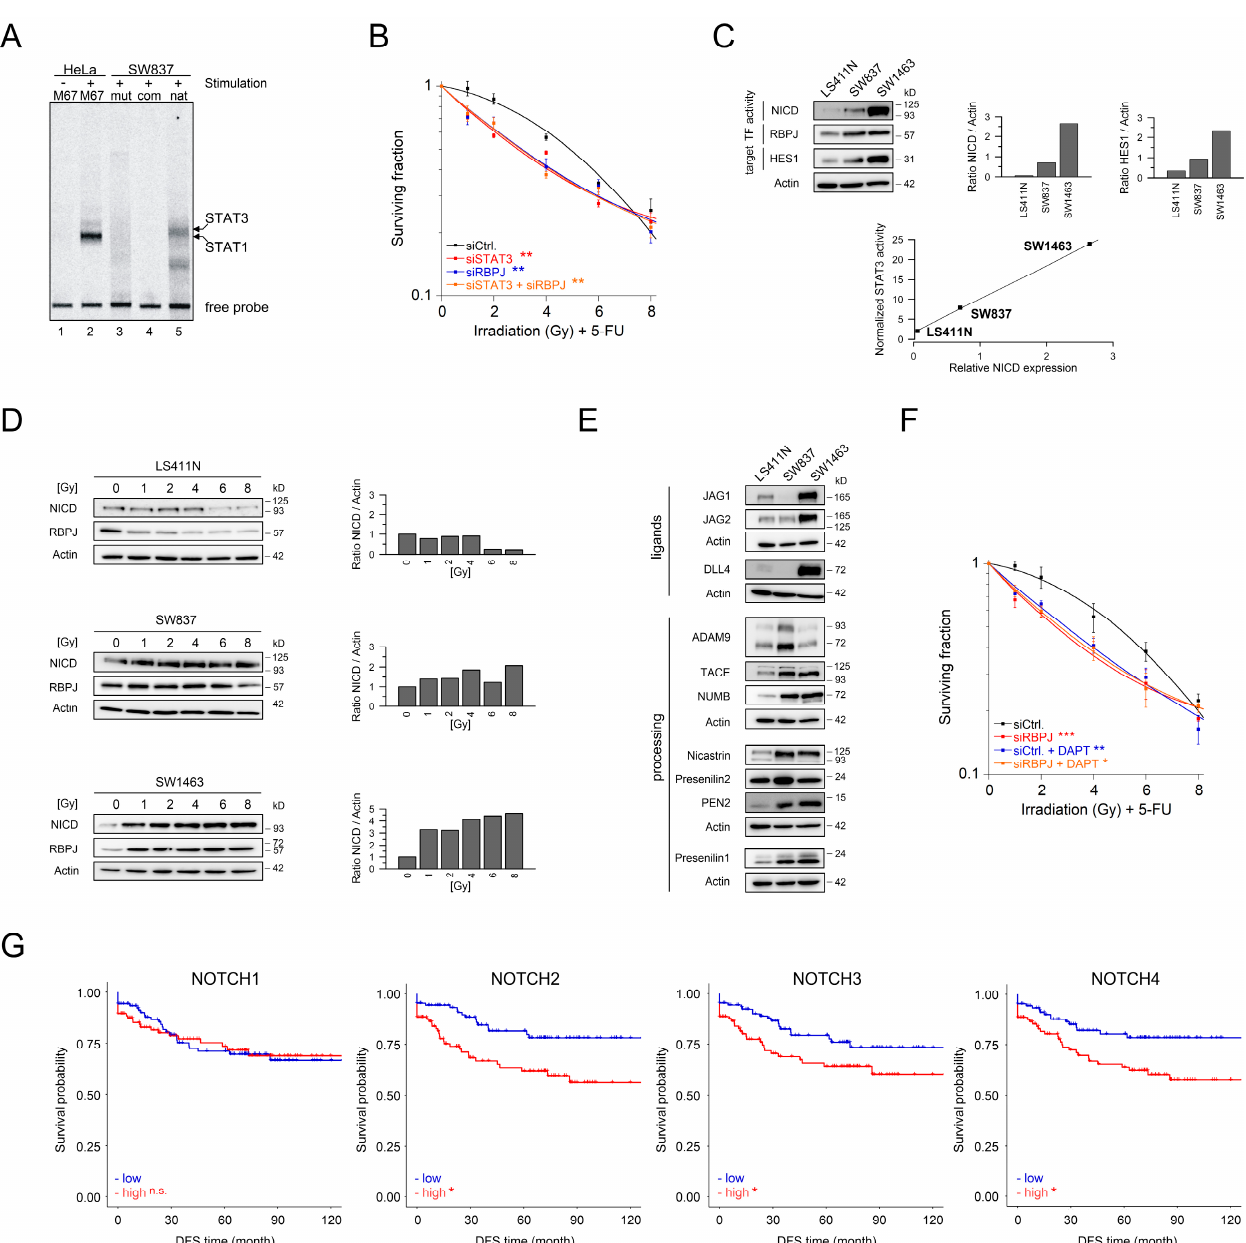
Figure 5. The gp130/STAT3 axis connects with the RBPJ/NOTCH pathway. ( A ) Binding of STAT proteins to [ 33 P]-labeled oligonucleotides encompassing prototypic GAS (M67), a mutated GAS (mut) or the native GAS element (nat) from the RBPJ promotor, was analyzed by EMSA using extracts of unstimulated or IFN- γ -stimulated HeLa cells, or Hyper-IL-6-stimulated SW837 cells. The radioactively labeled M67 probe was outcompeted (com) by incubating lysates with an excess of unlabeled M67 probe. Labeling of STAT1 and 3 is based on their documented migration pattern in double-positive cells in which STAT3 can be distinguished from STAT1 by its slower electrophoretic mobility [36] ( B ) CFA of SW837 cells after RNAi against STAT3 and RBPJ , either alone or in combination. ( C ) Expression analysis of NOTCH pathway components. ( D ) Immunoblotting of NICD and RBPJ presence following irradiation. ( E ) Expression analysis of γ -secretase complex and additional NOTCH pathway components. ( F ) CFA of SW837 cells after RNAi against RBPJ and after treatment with the γ -secretases inhibitor DAPT, either alone or in combination. ( G ) Survival curves of 207 rectal cancer patients who were treated with preoperative CRT. Survival data were plotted against pretherapeutic gene expression levels of NOTCH1-4 , respectively. Data of CFA experiments presented as mean ± s.e.m. from at least n = 3 independent biological replicates. * p < 0.05, ** p < 0.01, *** p < 0.001, two-way analysis of variance (ANOVA). For p -values see Table